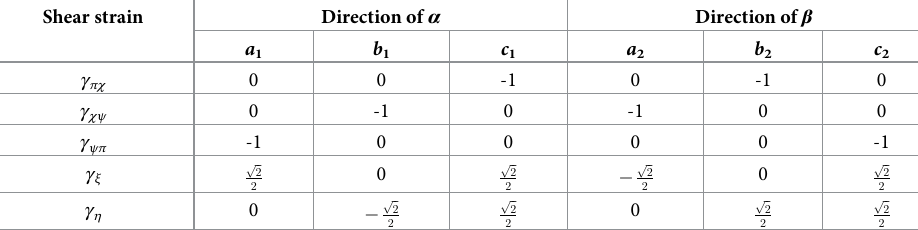
Table 1. Direction vector of shear strain defined by a quadrangular pyramid. Shear